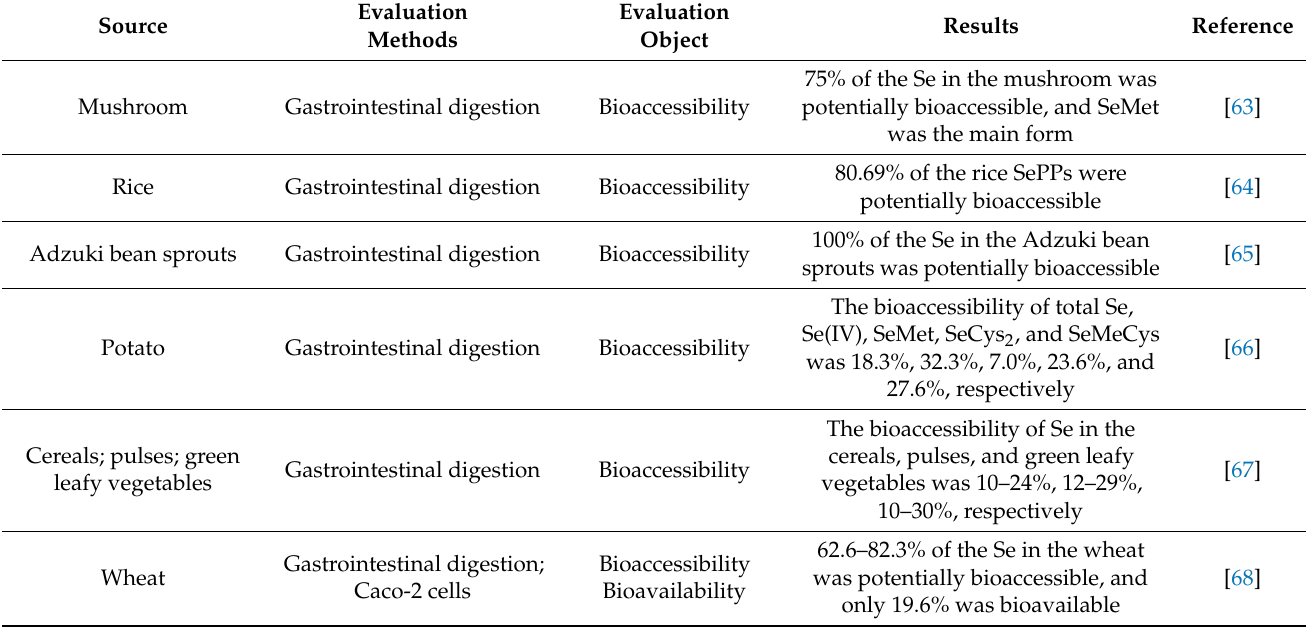
Table 3. In vitro and in vivo evaluation of selenium in